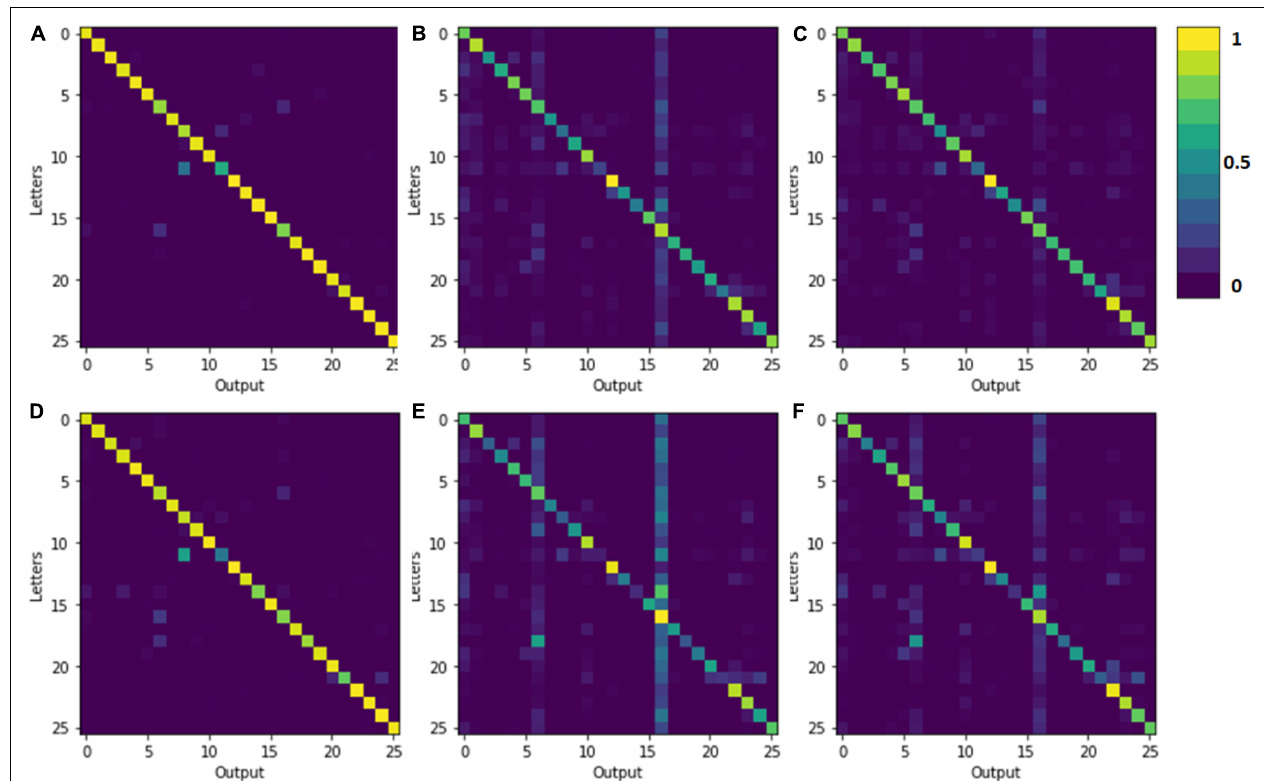
FIGURE 5 | The confusion matrix obtained after testing the samples. (A,D) The initial samples, (B,E) the noise samples, and (C,F) the denoising samples for the unquantized CNN and the quantized CNN, respectively. The ordinate denotes 26 input testing letters, and the abscissa denotes the output and recognition